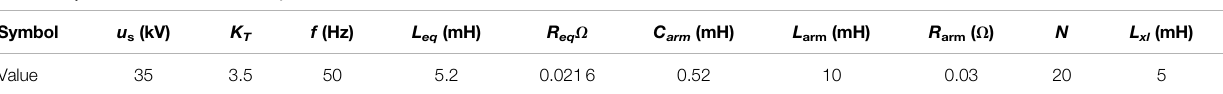
TABLE 3 | Parameters of the MMC systems.